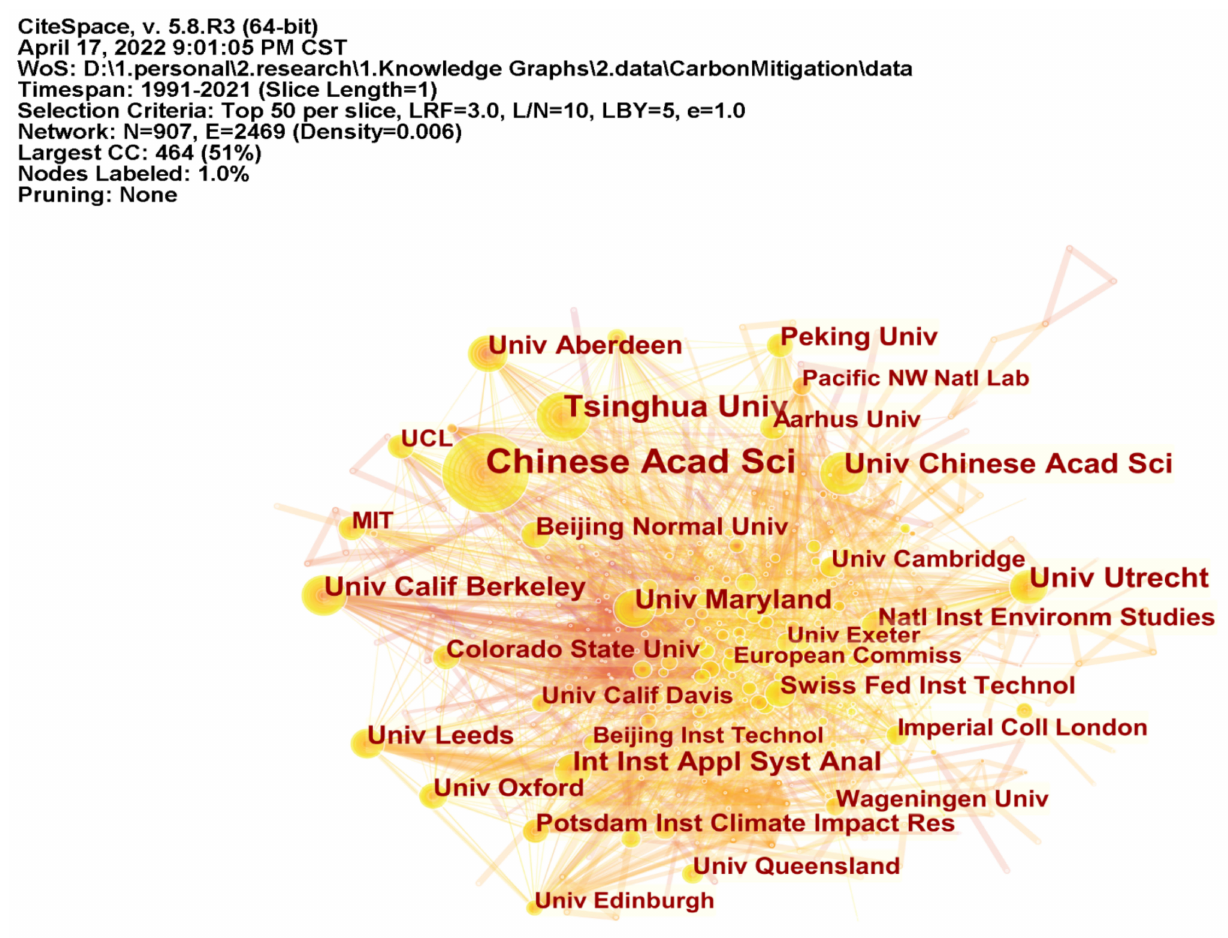
Figure 4. Cooperation Network of Institutions in the Field of Carbon Emission Reduction